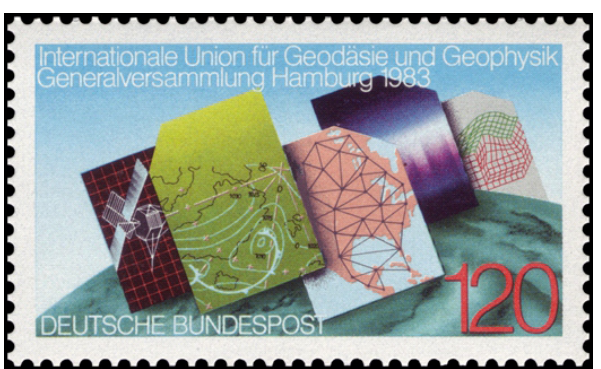
Figure 5. Stamp celebrating the XVIII IUGG General